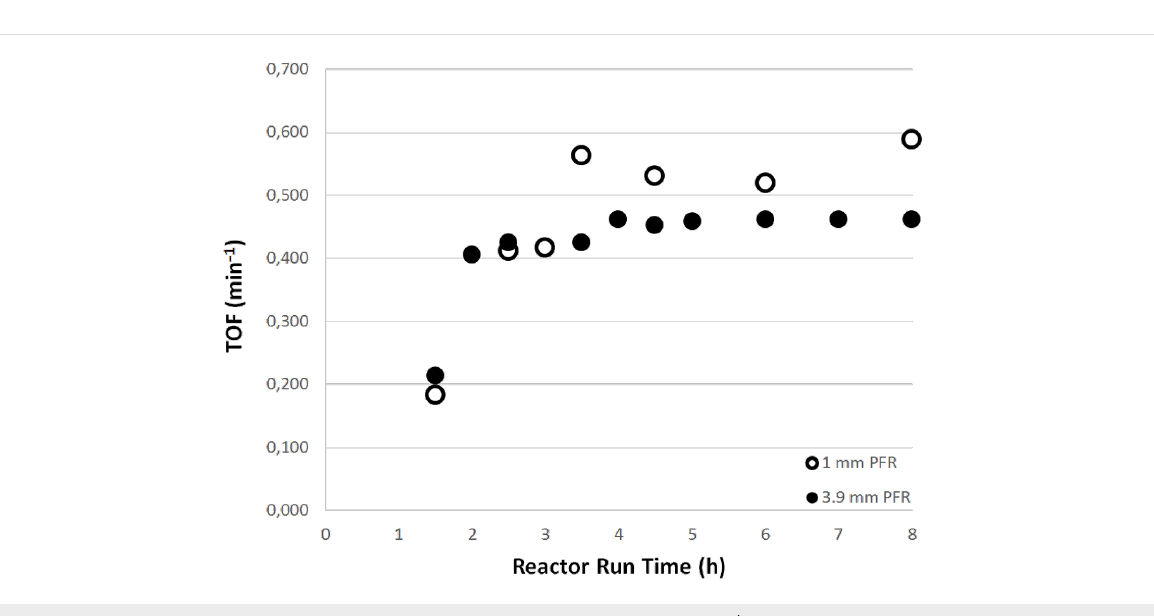
Figure 8: TOF values for the 1 mm ( ο ) and 3.9 mm ( ● ) PFRs at a total flow rate of 0.12 mL min − 1 , 155 °C and 200 bar for the reaction of 4-iodo- anisole with methyl